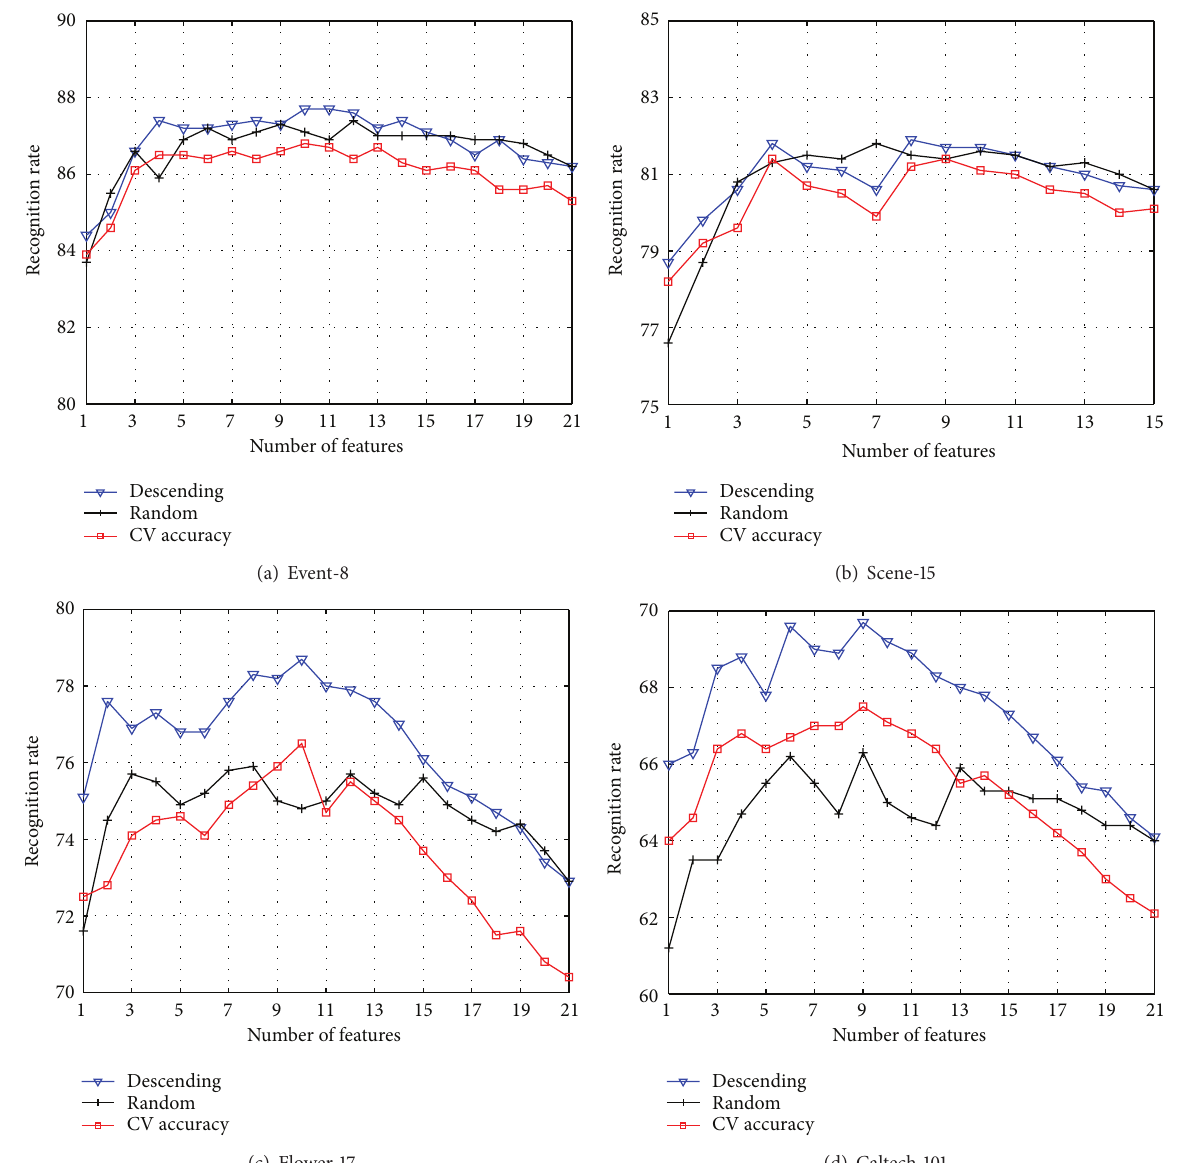
Figure 2: Comparison of average combination in descending order and in random order. The cross-validation accuracy in descending order is also